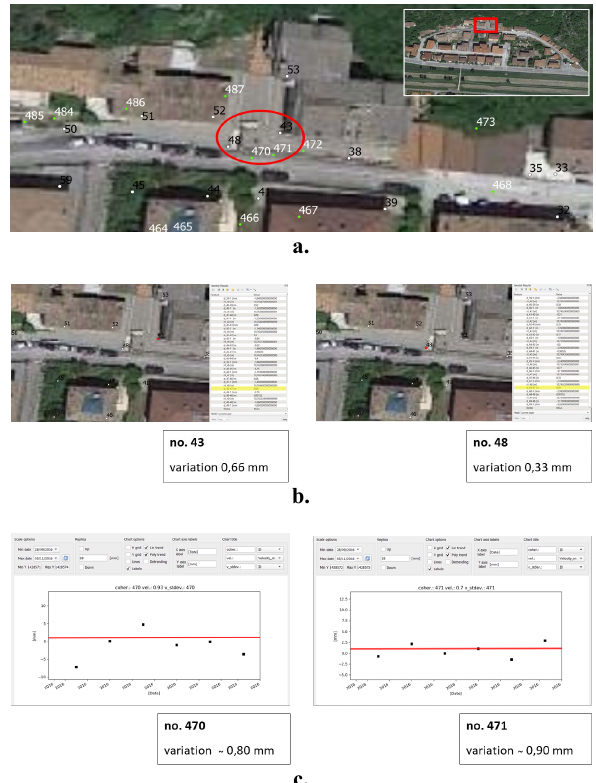
Figure 12. Post-seismic pointwise analysis between “stable points”. a. Identification of points on map; b. Points from topographic levelling c. Points from DInSAR.